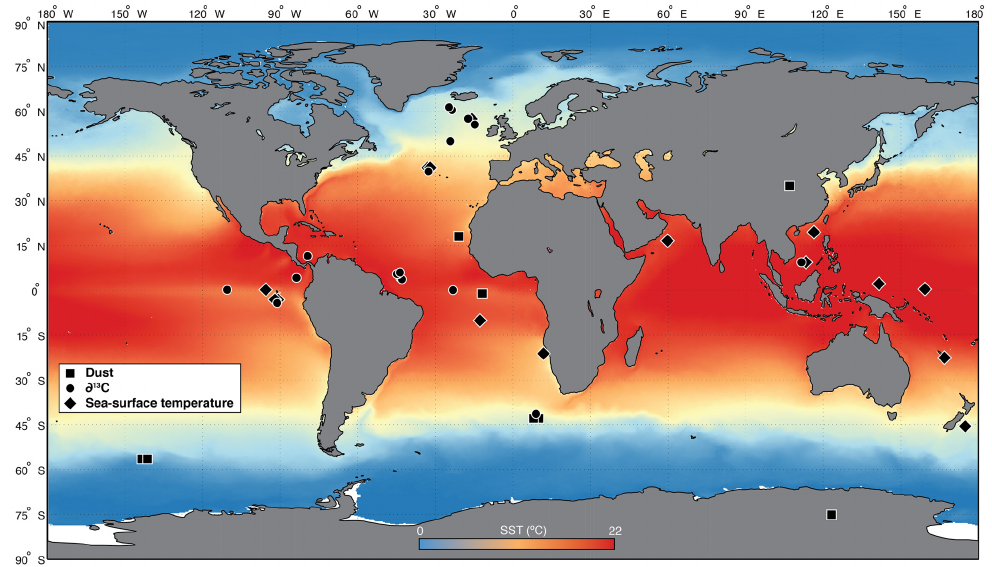
Figure 2. Site locations. Map indicating the locations of the cores used in this research and modern sea-surface temperature values. Each symbol represents a different proxy record. Diamonds indicate sea-surface temperatures. Circles indicate benthic ∂ 13 C. Squares indicate